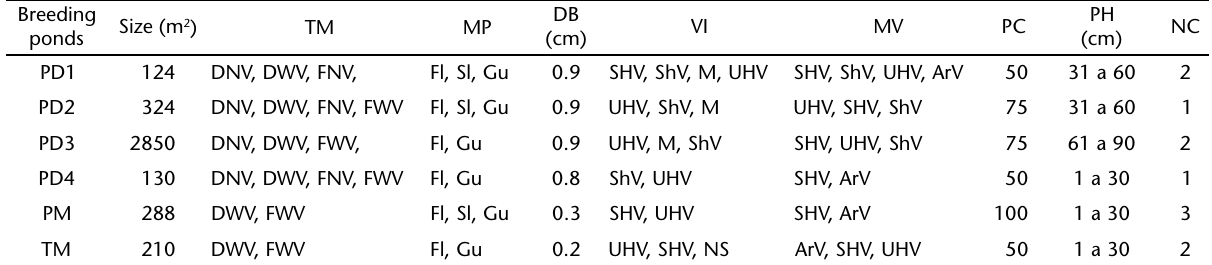
Table I. Environmental descriptors of breeding ponds studied: (PD) permanent dams, (TM) temporary marsh, and (PM) permanent marsh. (BD) Breeding pond hydroperiod, (TM) type of margin, (MP) margin slope, (PC) percentage of vegetation on water surface, (NC) number of plant clusters, (PH) predominant height of the vegetation, (VI) vegetation, (MV) marginal vegetation, SB) size, and DB) depth. Types of margins: (DNV) dry without vegetation, (DWV) dry with vegetation, (FNV) flooded without vegetation, (FWV) flooded with vegetation. Type of margin slope: (Fl) flat, (Sl) slope, (Gu) gully. Vegetation: (ShV) shrubby vegetation, (ArV) arboreal vegetation, (M) macrophytes, (UHV) upright herbaceous vegetation, (SHV) small herbaceous vegetation, (NS) nude soil. Number of vegetation clusters within the